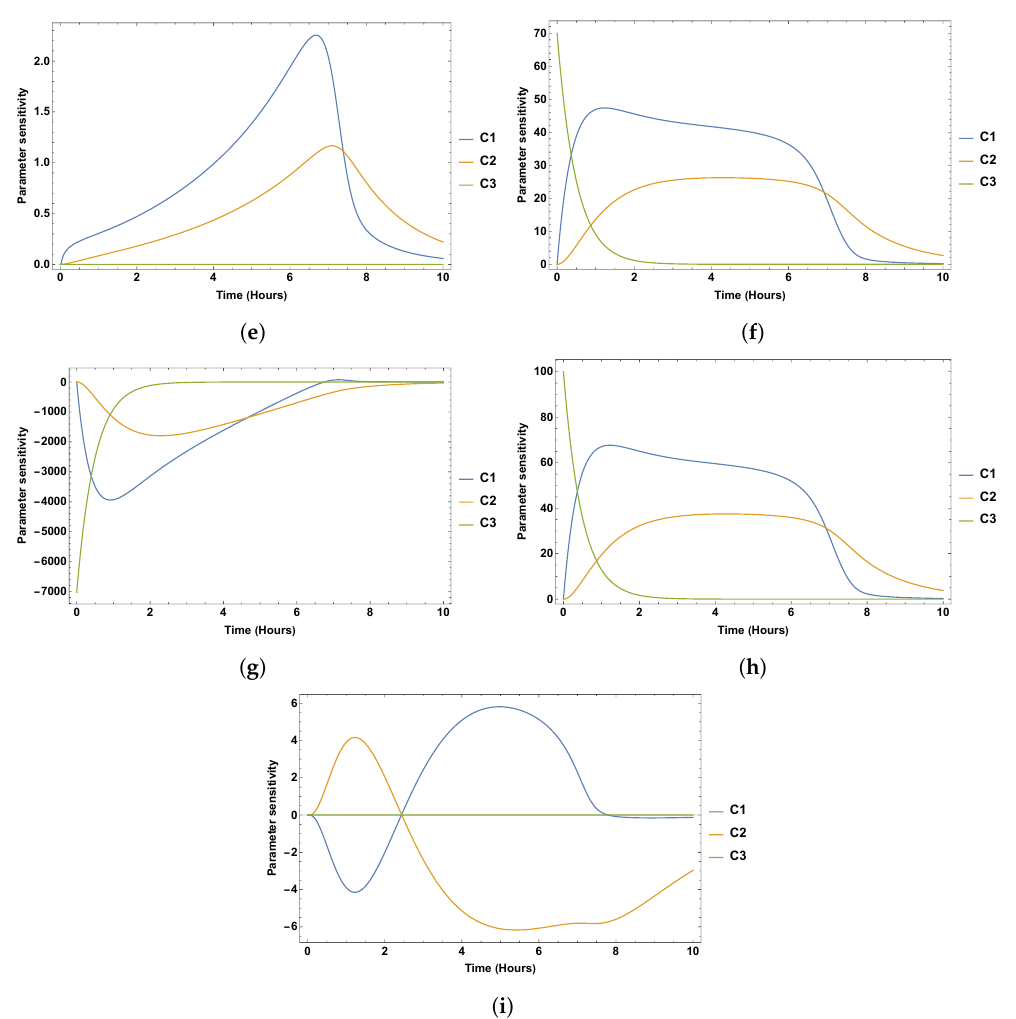
Figure 5. Oral dose sensitivity analysis. ( a ) Transfer rate, k 12 . ( b ) Degradation rate, k 21 . ( c ) Absorption rate constant, k a . ( d ) Maximum rate of elimination, V m . ( e ) Michaelis–Menten constant, K m . ( f ) Dose, D . ( g ) Central Volume of distribution, V 1 . ( h ) Bioavaliablity fraction, F . ( i ) Fractional order, α